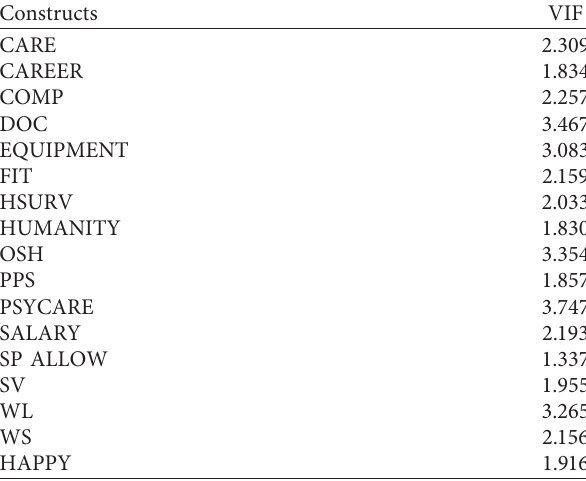
Table 2: Full collinearity testing.